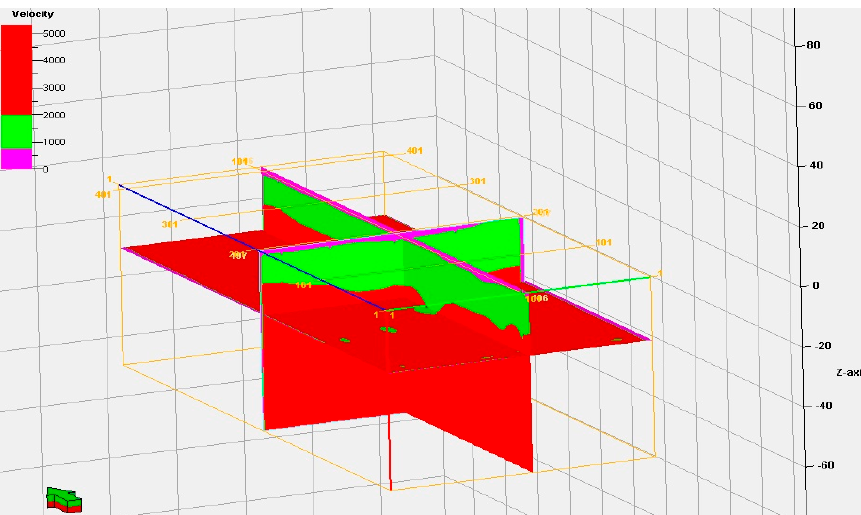
Figure 17. The final velocity model which was used for geologic interpretation. The cross sections are along Line 0001 and Line 0002. The green arrow points to the west. Red indicates till of the Delavan Formation, green is the Henry Formation outwash, and purple is the Cahokia Formation alluvium. Geosciences 2016 , 6 , 9